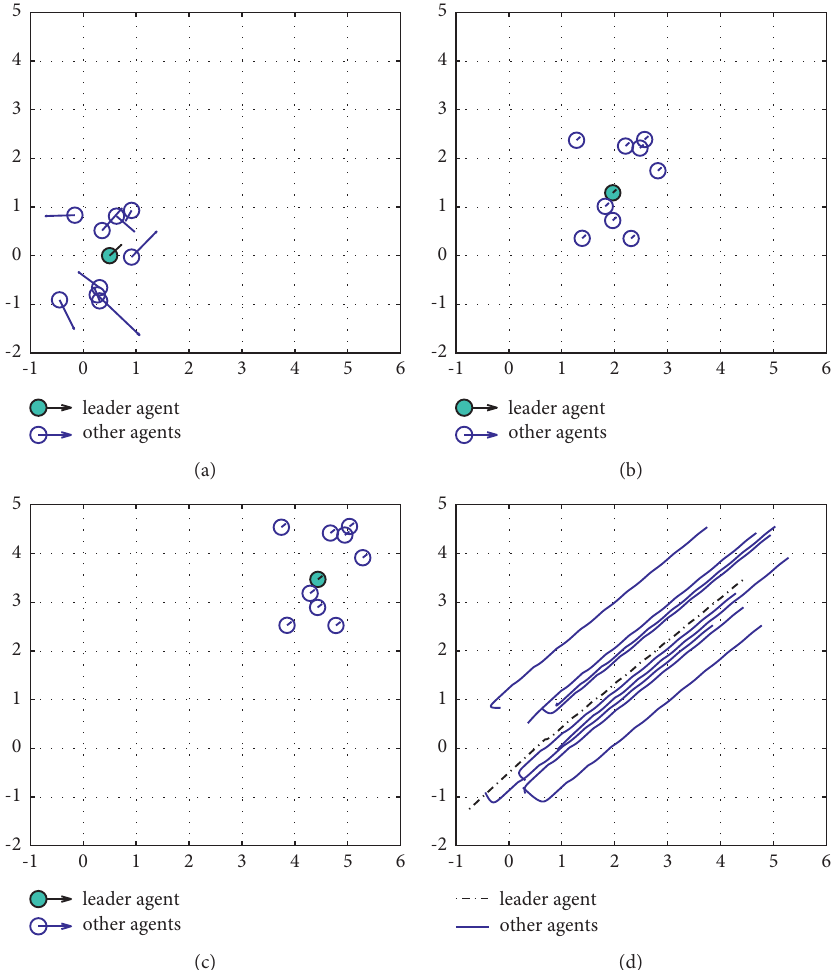
Figure 2: The simulation of the leadership of CS model with time delay τ � 2 for one leader and nine followers in two dimensions. Parameters in the connectivity function are chosen as K � 2 , σ � ( 1/4 ) and leader interaction force is given as c � 10. (a)–(c) present the positions of the agents and their velocities at time t � 0, t � 20, t � 50, respectively. The circles represent the positions of each agent and the shaded circle denotes the leader. (d) shows trajectories of agents in t ∈ [ 0 , 50 ] . (a) Initial configuration. (b) t � 20. (c) t � 50. (d) Trajectories of